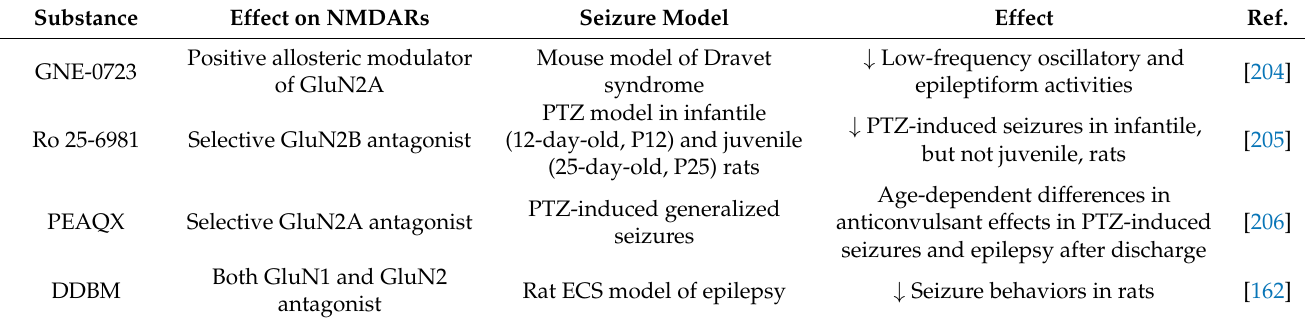
Table 1. Anticonvulsive effects of newer NMDAR antagonists in pre-clinical